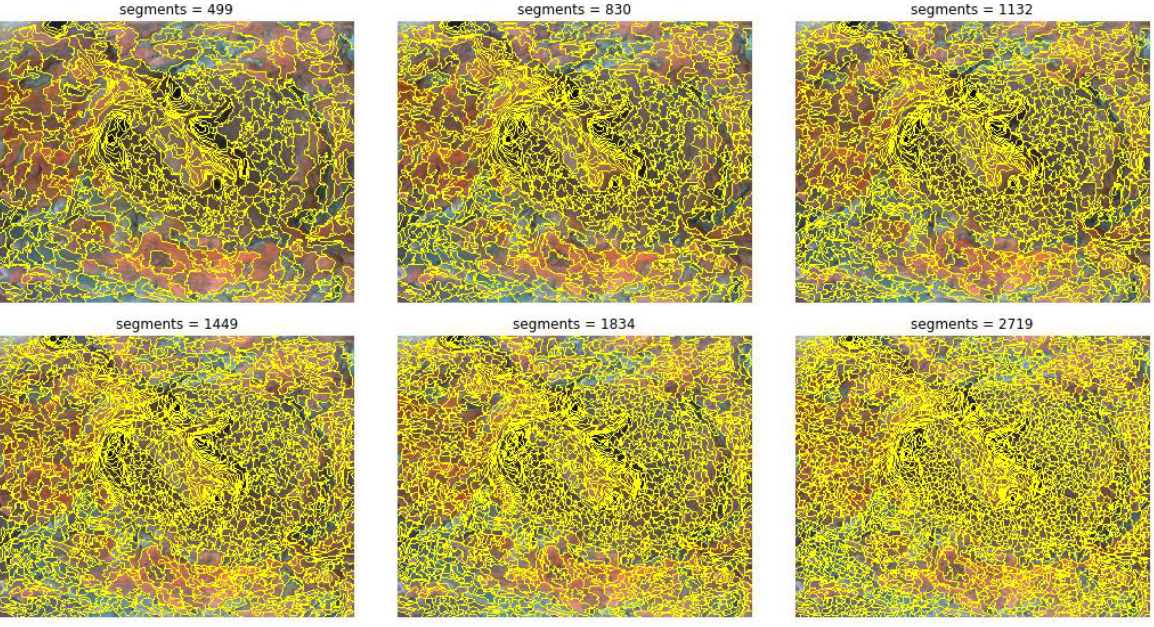
Figure 8. Superpixel segmentation results of FRT00003e12 (unprojected) by SLIC with different input parameter (segments), the titles show the actual number of segments in each figure. The base map is the default false color of 3e12 (R:2.529μm, G:1.506μm, B: 1.080μm), the boundaries are represented by yellow lines. The denser the boundaries, the finer the segmentation.